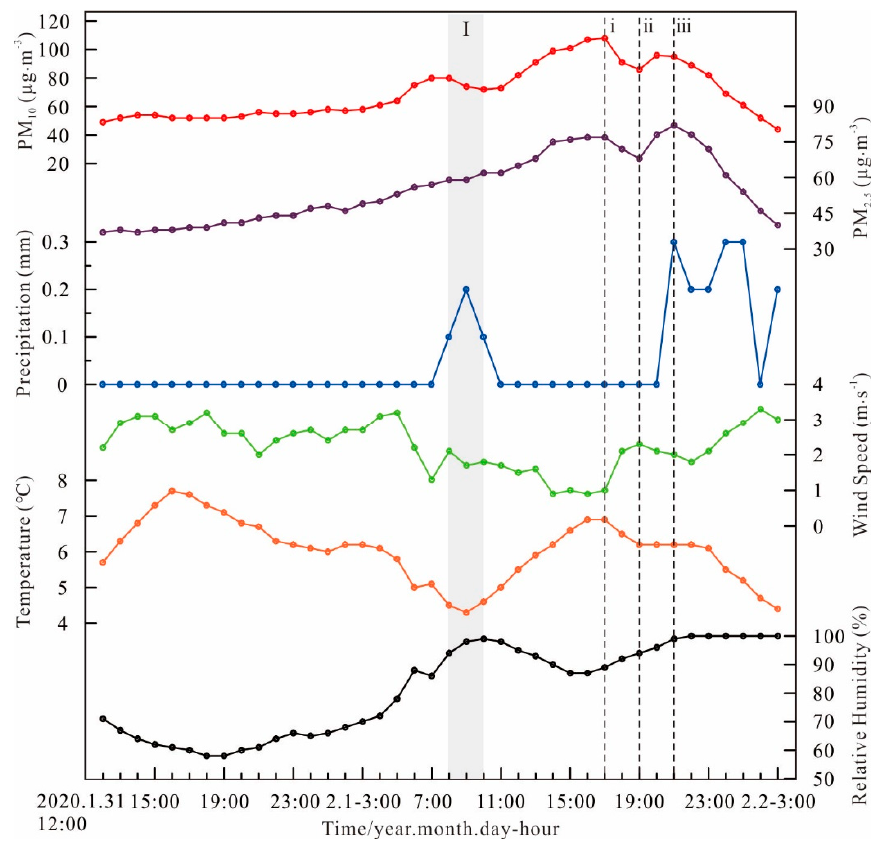
Figure 5. Variations of PM 10 , PM 2.5 concentration, and meteorological parameters from 12:00 on 31